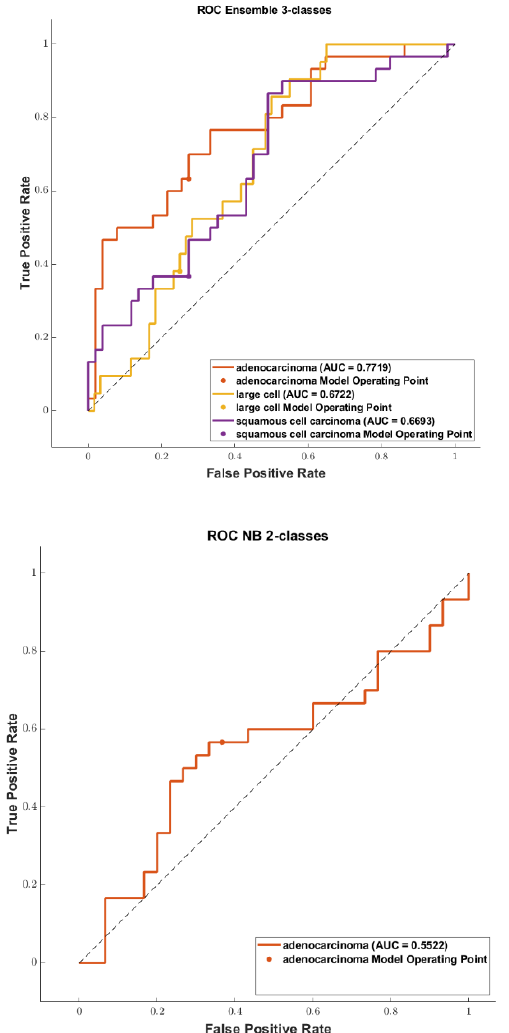
Figure 15. ROC curves for the harmonized datasets: ( top ) The 4-classes datasets, ( middle ) 3-classes datasets, and ( bottom ) 2-classes datasets .